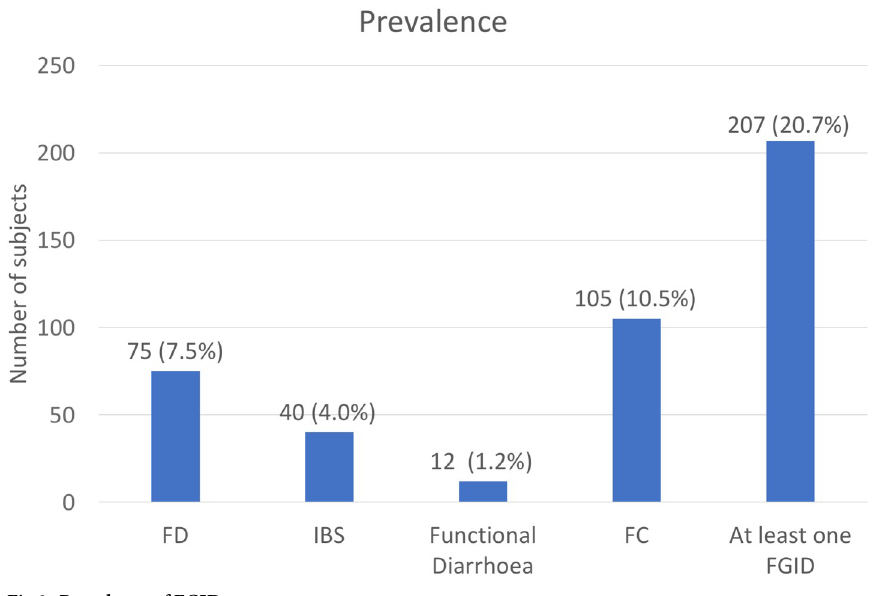
Fig 2. Prevalence of